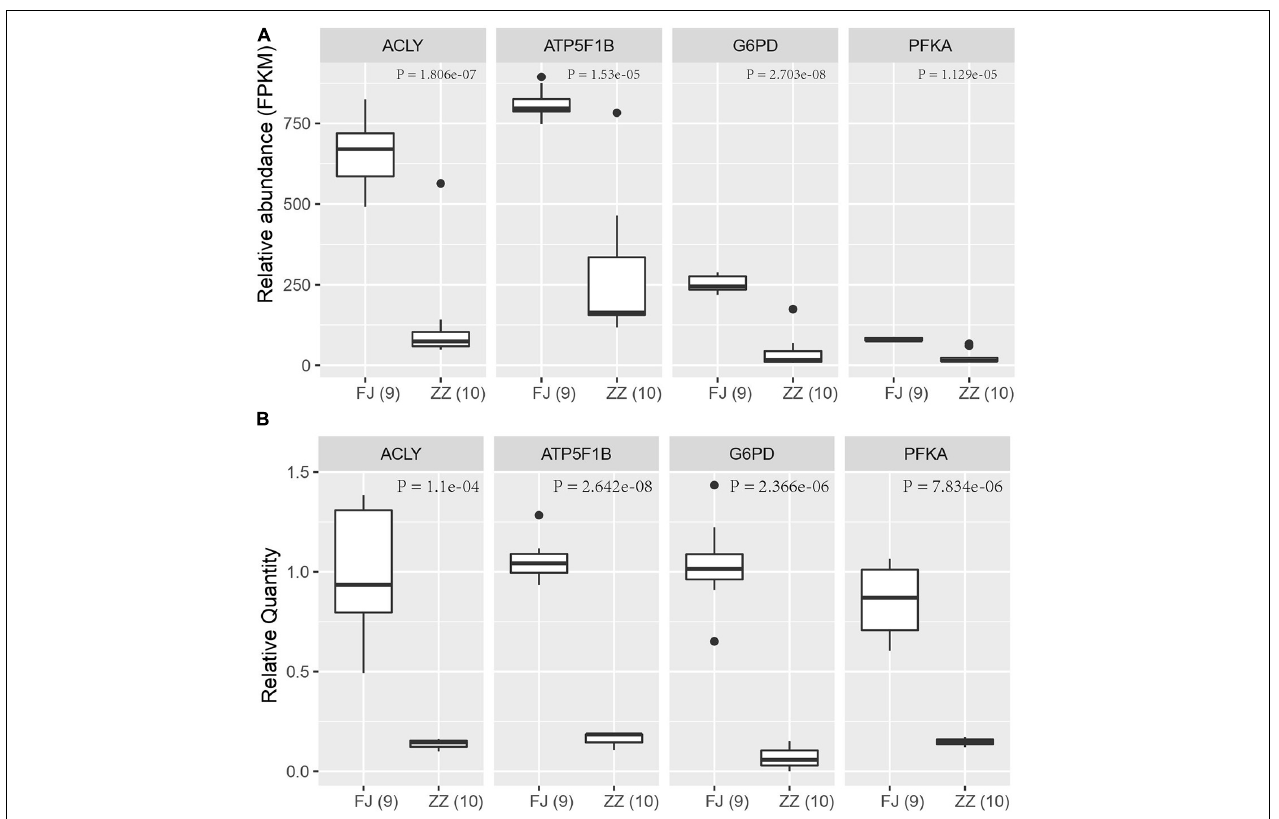
FIGURE 8 | The qPCR validation of four differentially expressed genes in the Sirtuin pathway. (A) The relative abundance of four DEGs based on FPKM in RNA-Seq data. (B) The relative quantity (RQ) of four DEGs by qPCR assay. The significant difference of the infected group (ZZ) and the healthy group (FJ) was analyzed by t -test with P <